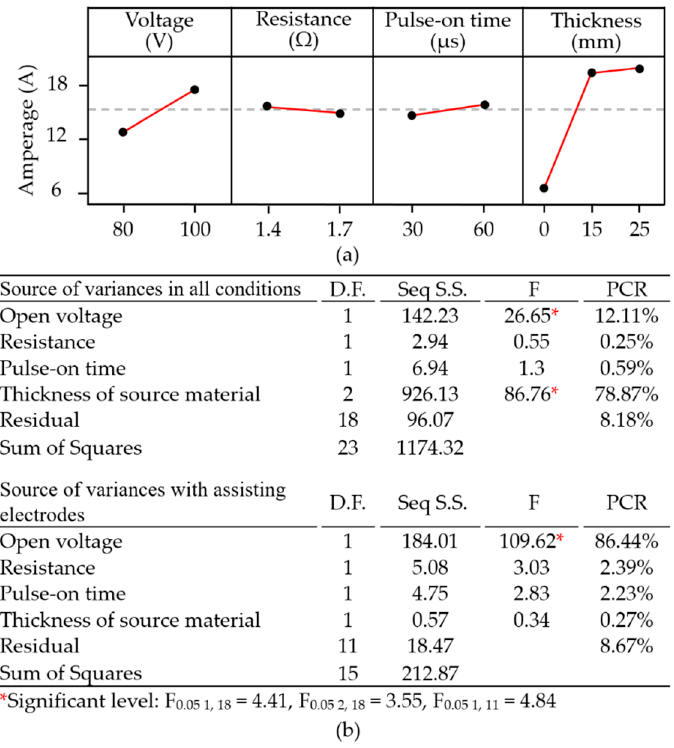
Figure 7. Statistical examination of main effect plots: ( a ) with operating parameter settings for assisting electrodes; ( b ) ANOVA results for discharging current.